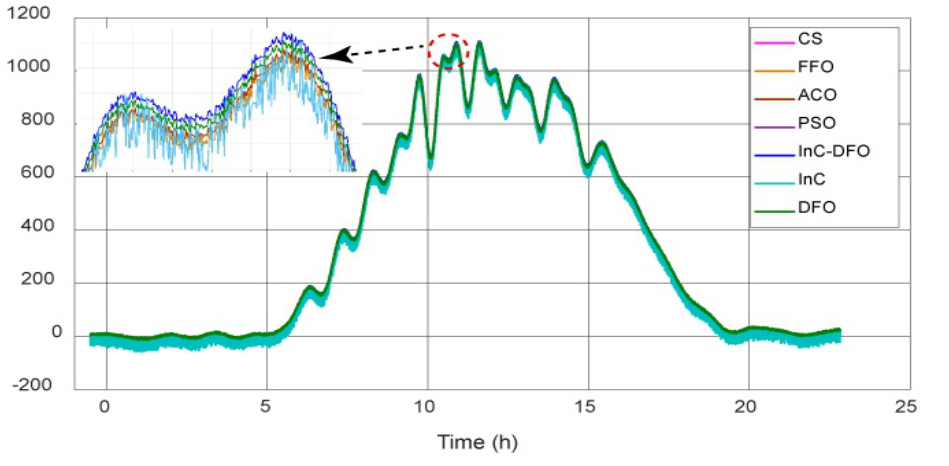
Figure 14. Power comparing of Spring in Beijing of InC–DFO algorithm with CS, FA, ACO, PSO, InC, and DFO.